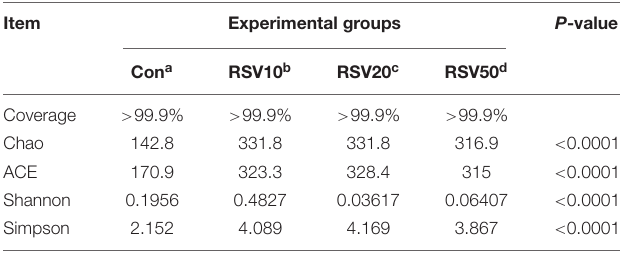
TABLE 3 | Alpha diversity indices of bacterial communities in the cecum content of weaned mice. Item Experimental groups